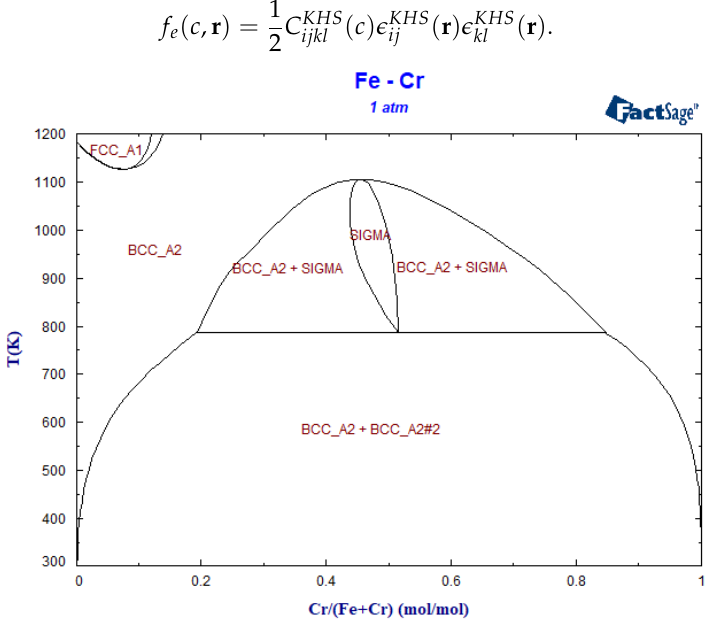
Figure 1. Plot of the phase diagram in Fe-Cr system using FactSage thermochmical